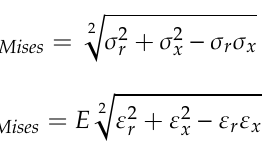
Figure 23. ( a ) The backfilling schematic of Condition 04; ( b ) the stress distribution of the pipe; ( c ) the time history curve of the left springline under Condition 04.